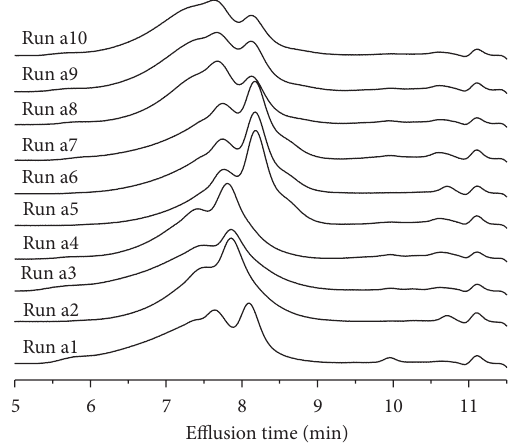
Figure 4: GPC spectrogram of the PLA chain extender with HDI.